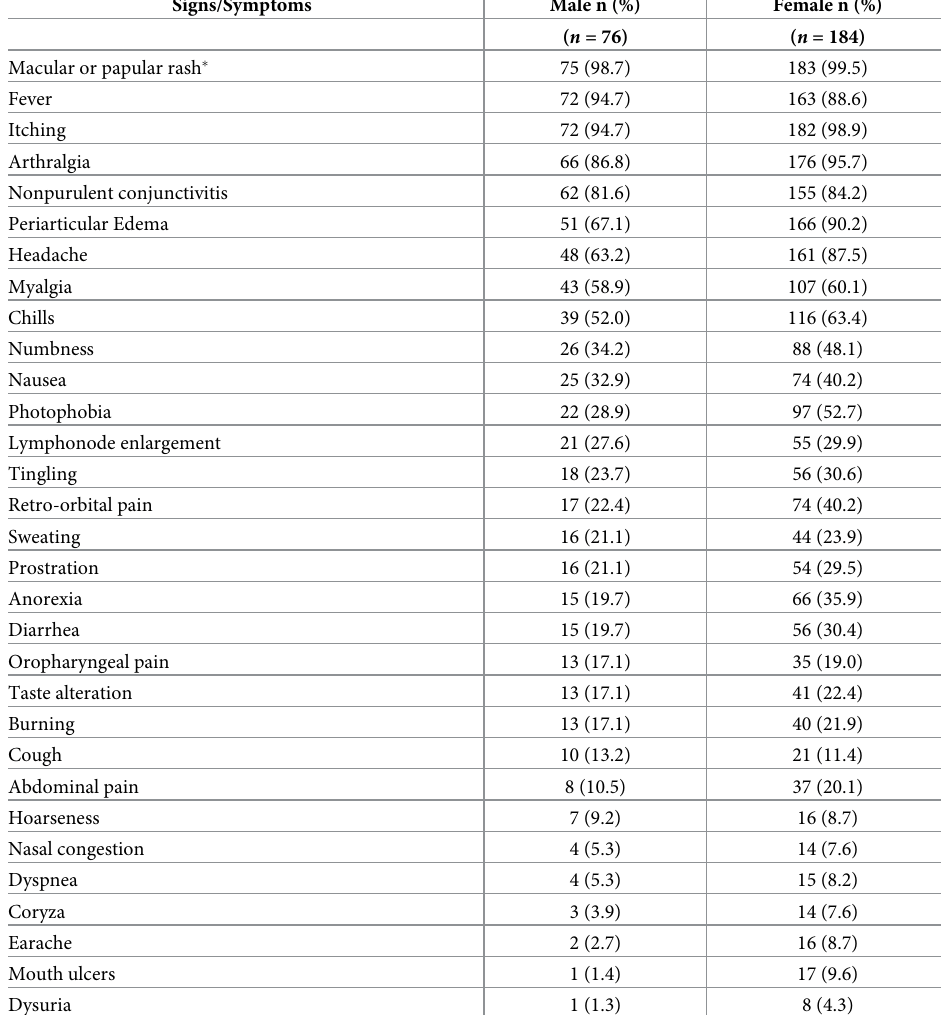
Table 4. Signs and symptoms at enrollment since the onset of disease of 260 study participants of the ZIKABRA study, by sex.